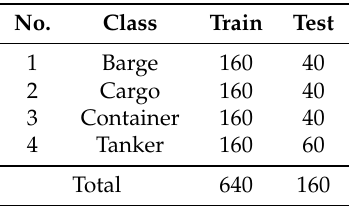
Table 3. Selected classes for evaluation and the numbers of training and testing set for the original BCCT200